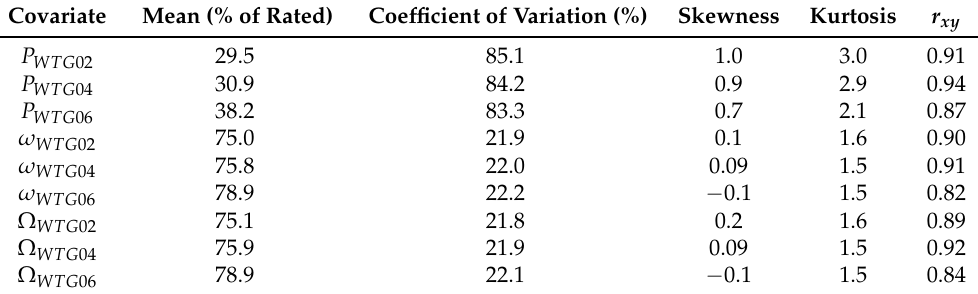
Figure 4. Scatter plot representation of the D bef data set: in y -axis, the power of the target wind turbine WTG05 and in the x -axis the powers of the reference wind turbines ( left ), the rotor speeds of the reference wind turbine ( right ). All the measurements are represented in units of the rated. Table 1. Statistical indicators of the covariates matrix X for the data D bef and Pearson coefficient with the output.